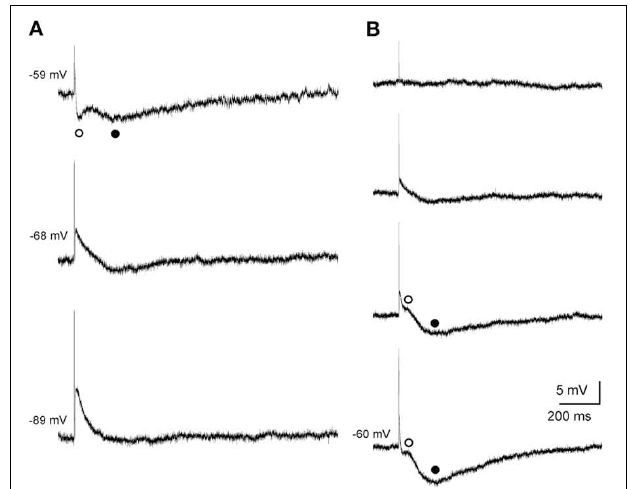
FIGURE 2 | Postsynaptic septohippocampal response in CA3 pyramidal neurons. (A) Effect of membrane potential variations on the amplitude of the early and late IPSPs evoked by orthodromic activation in a pyramidal CA3 neuron. Stimulation of the fimbria elicited an EPSP followed by an early (open circles) and late (closed circles) IPSP. Traces shown are the average of five responses. (B) Effect of varying the intensity of fimbria stimulation on the complex postsynaptic response recorded in another neuron at a membrane potential of − 60mV. From top to bottom, traces represent synaptic responses which were evoked by progressive increments in fimbria stimulation. Stimulation of the fimbria at a low intensity evoked only EPSP followed by an early ( ◦ , open circles) IPSP. Delivery of stimulation at higher intensities resulted in the elicitation of a subsequent late ( • , closed circles) IPSP. The approximate reversal potential for both inhibitory components was early − 61 . 1mV and late − 80 .